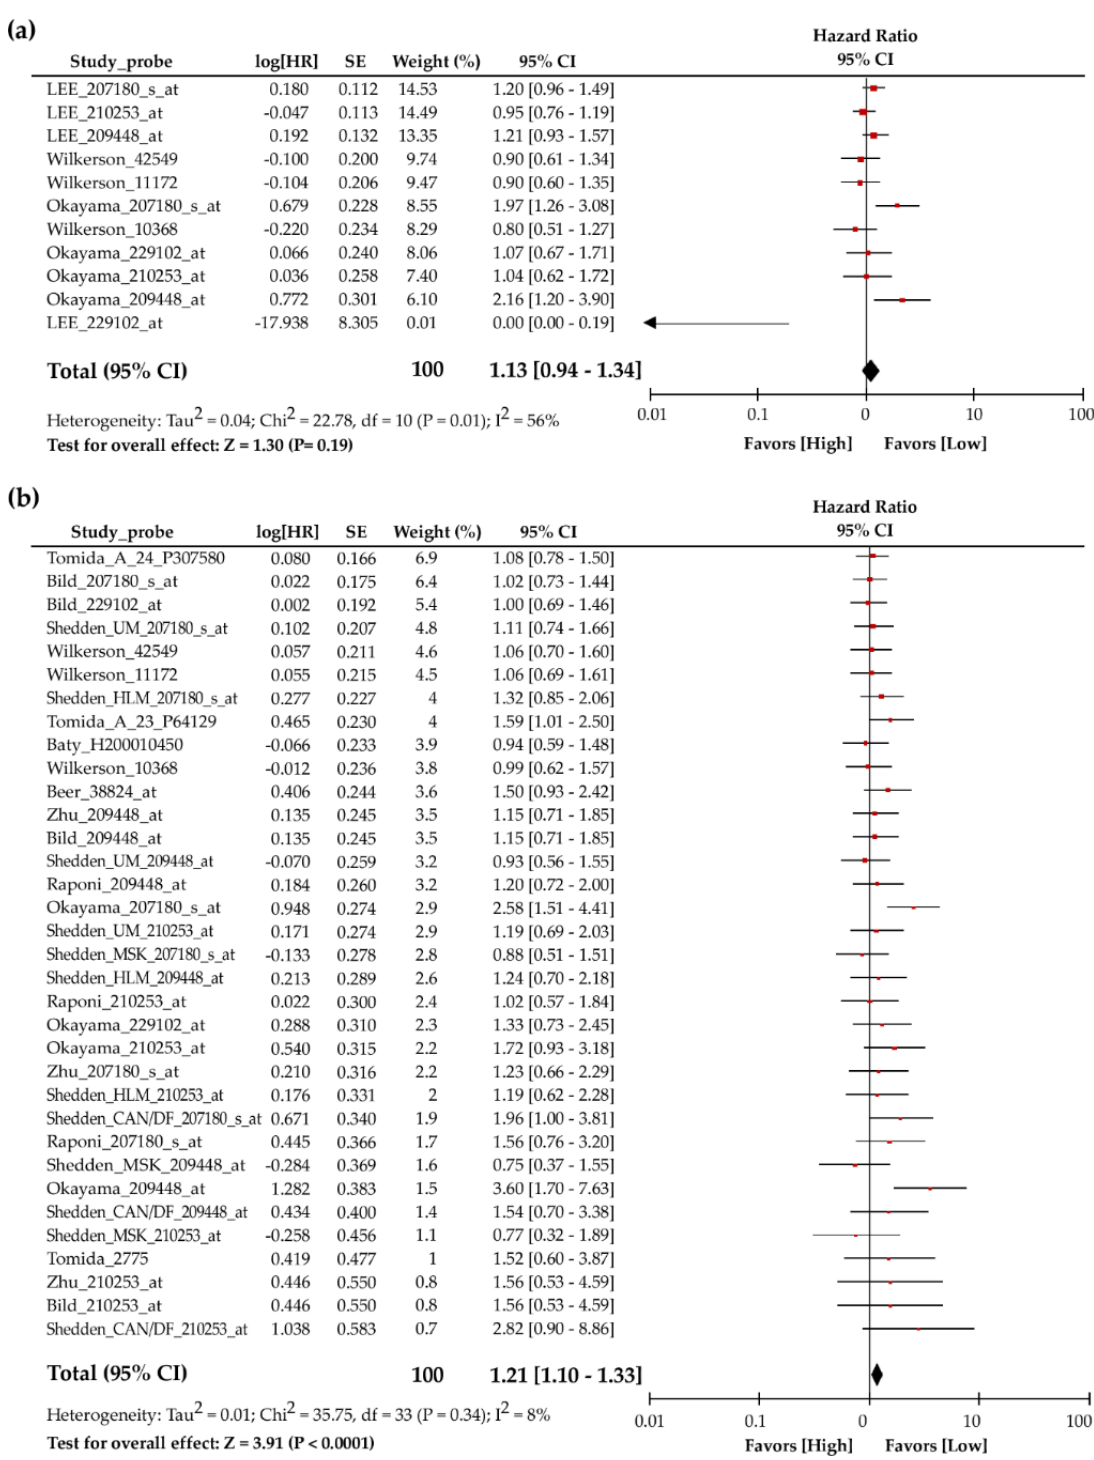
Figure 1. Association between TIP30 mRNA expression and the survival of non-small-cell lung cancer (NSCLC) patients. The horizontal bars in the forest plot represent the 95% confidence intervals of the hazard ratio of relapse-free survival. ( a ) Three publicly available microarray datasets encompassing 398 NSCLC patients were used for a meta-analysis of the association between TIP30 mRNA expression and relapse-free survival. ( b ) The meta-analysis of the TIP30 mRNA expression for the overall survival of NSCLC was performed by using 9 published microarray datasets encompassing 1325 NSCLC patients.